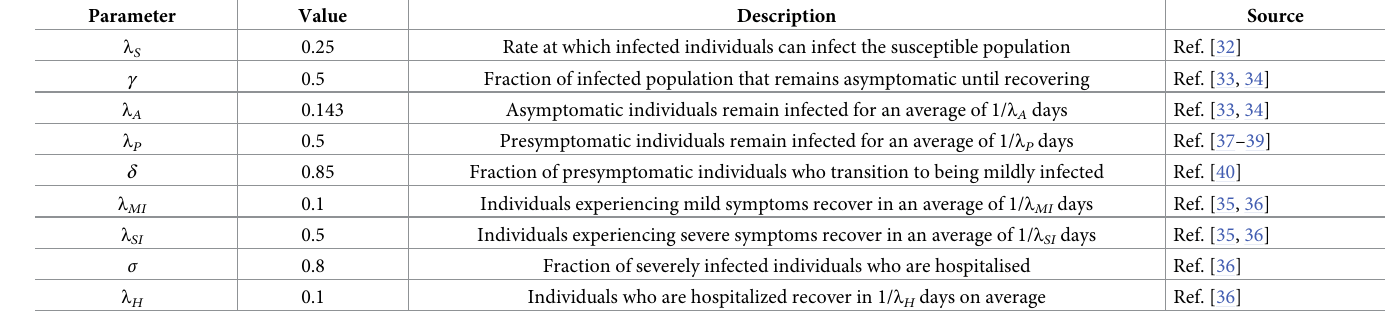
Table 1. The parameters used to specify the model include both rates for transitions between compartments as well as the probabilities of branching between them. These are within ranges found in the literature. We ignore deaths, since reported IFRs for COVID-19 in India are small ( < 0.1%). These are the parameters used for the simulation depicted in Fig